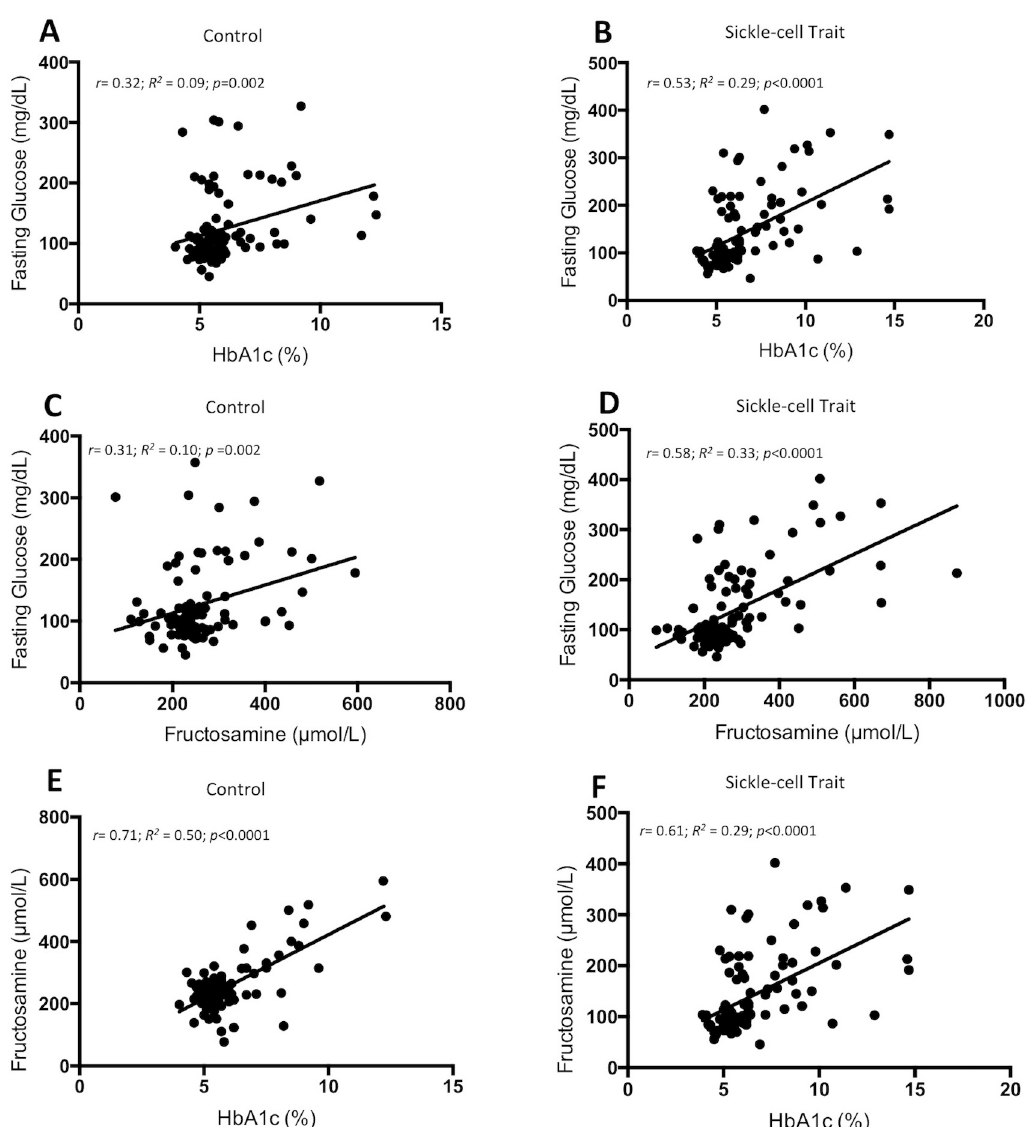
Fig 1. Scatterplots of glycated hemoglobin A1c (HbA1c) versus fasting glucose (FG), fructosamine versus FG, and HbA1c versus fructosamine for control and SCT groups. The best-fit model (solid line) is shown for each plot along with the coefficient of determination (R 2 ), the Pearson correlation coefficient, and the p-value of the